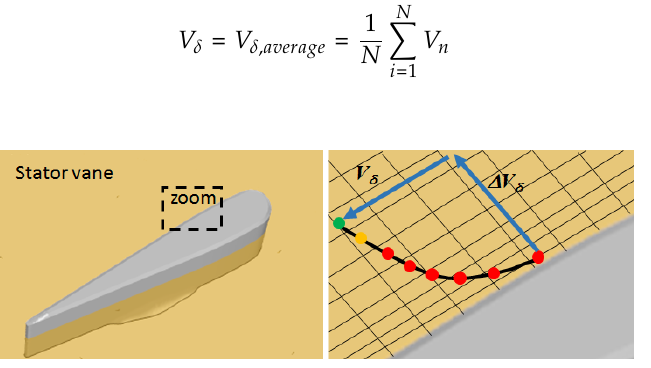
Figure 11. Boundary layer thickness explanation